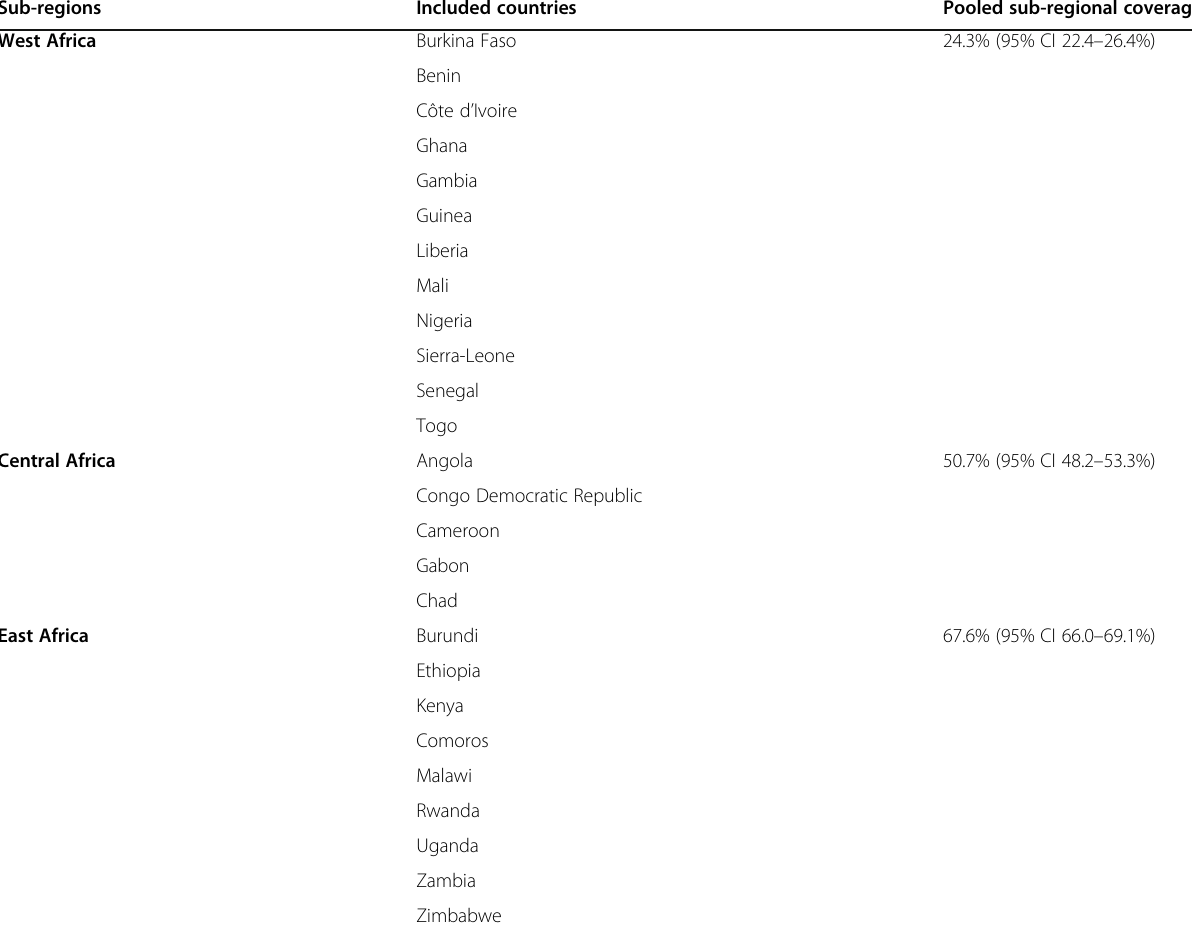
Table 3 Coverage of utilization of deworming medication among pregnant married women by sub-regions: evidence from 26 sub- Saharan African countries DHSs